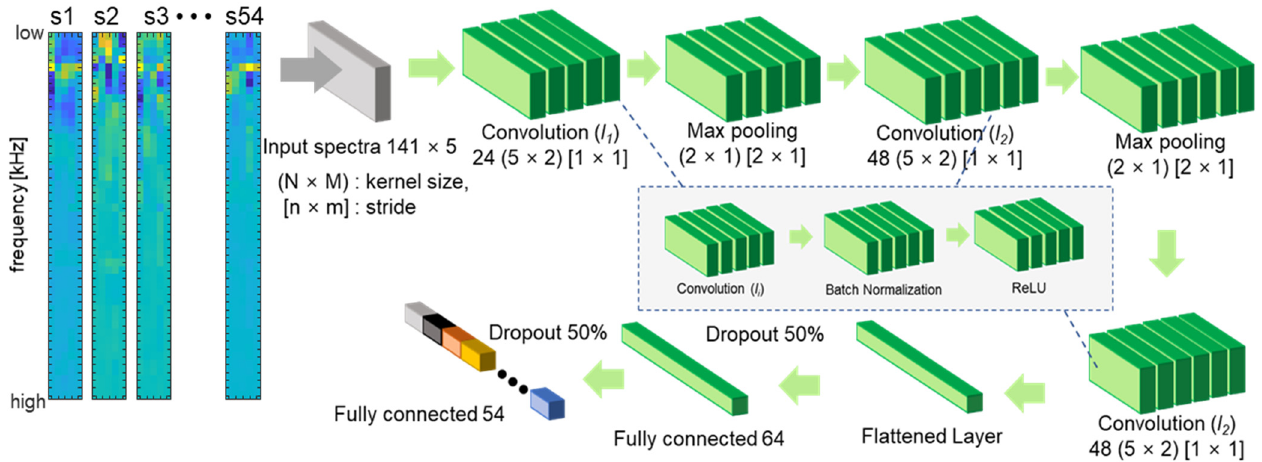
Figure 8. Architecture of the implemented CNN model. Five-channel finger data consisting of 141 samples from 54 subjects were converted into two-dimensional (141 × 5) forms and used as input.